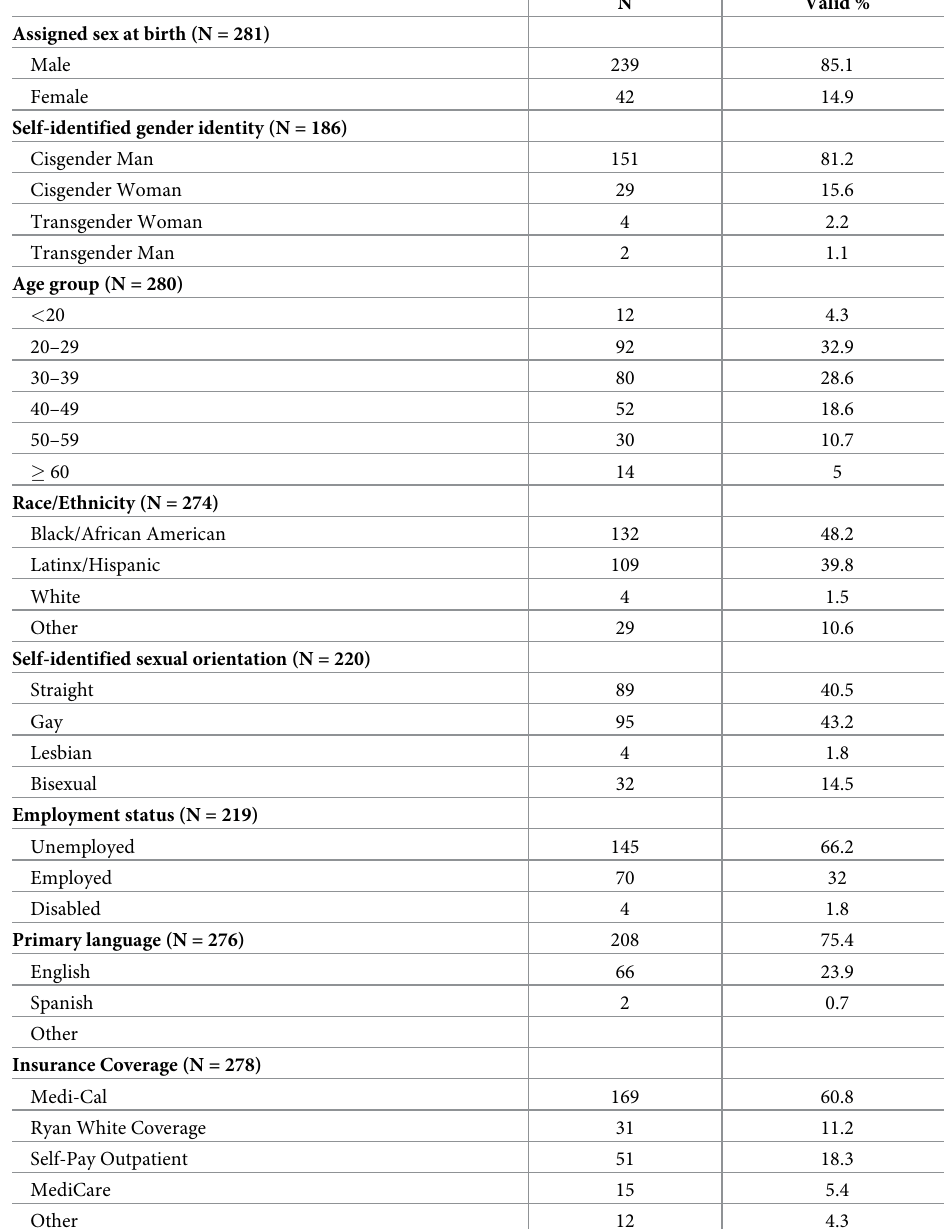
Table 1. Demographic characteristics of newly diagnosed HIV-positive clients in 2016–2020 (N =